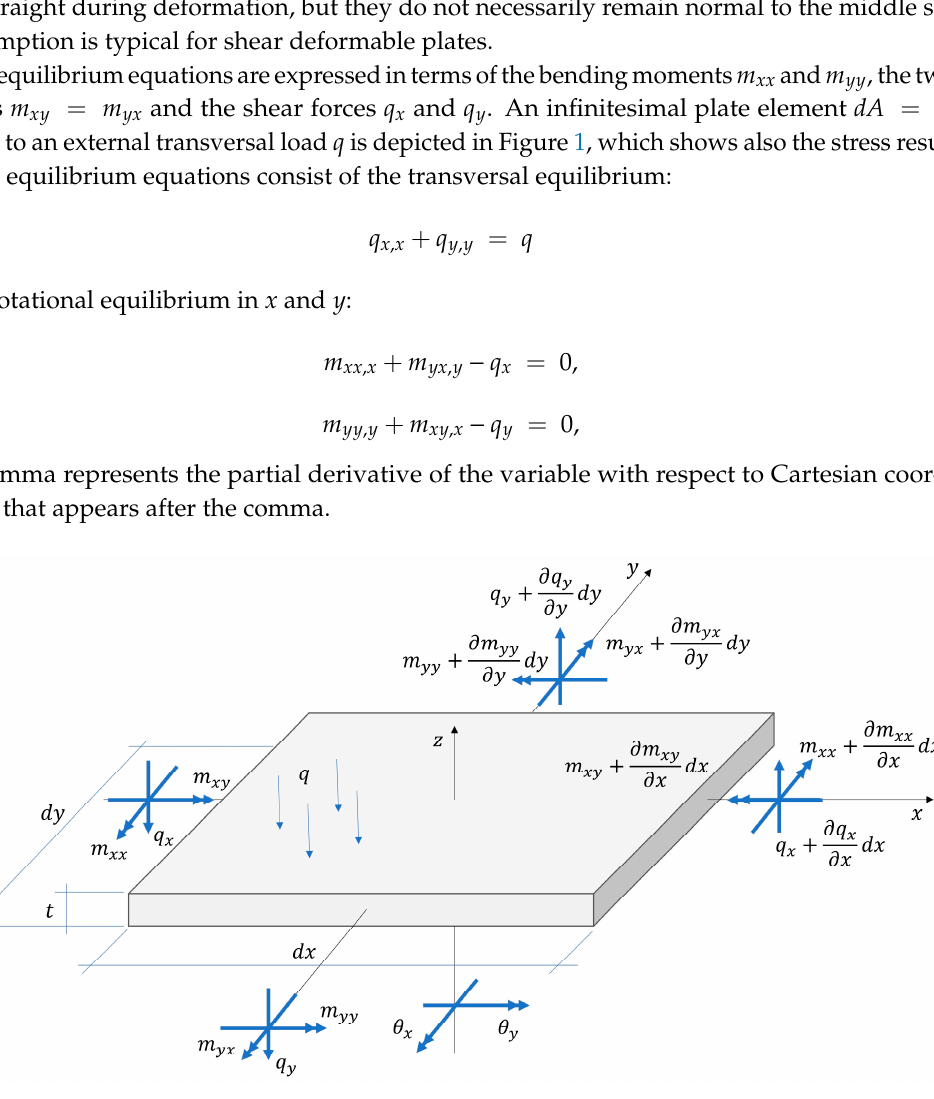
Figure 1. Plate stress resultants and rotations.